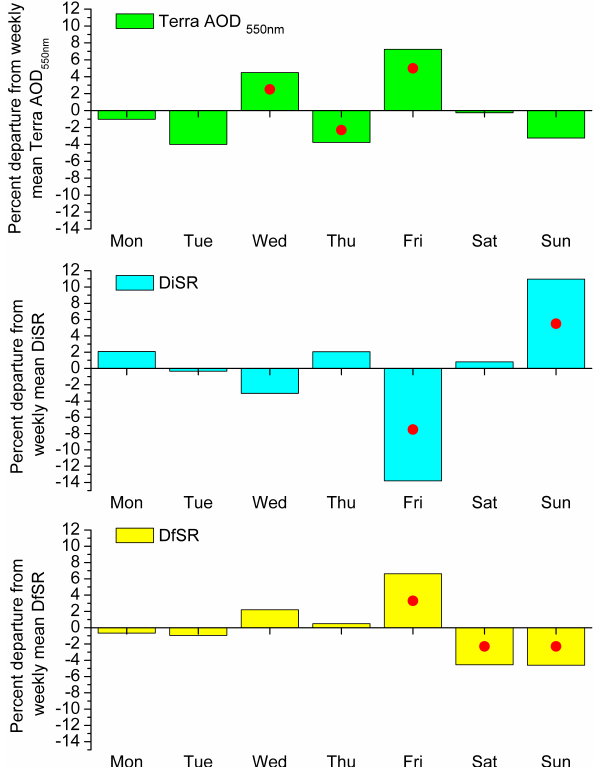
Fig. 7. Percentage departures of AOD (top), DiSR (middle) and DfSR (bottom) from their weekly averages in Shanghai. Red filled circles mean the departure from weekly average is above 90% con- fidence. The AOD data are from the MODIS Terra Level 2 prod- ucts (collection 005) at 550nm. Terra overpasses Shanghai between 09:00:00–10:00:00LT each day. The DiSR and DfSR are measured from 09:00:00 to 10:00:00LT, in line with the satellite passage. Sta- tistical data range from 1 January 2004 to 31 December